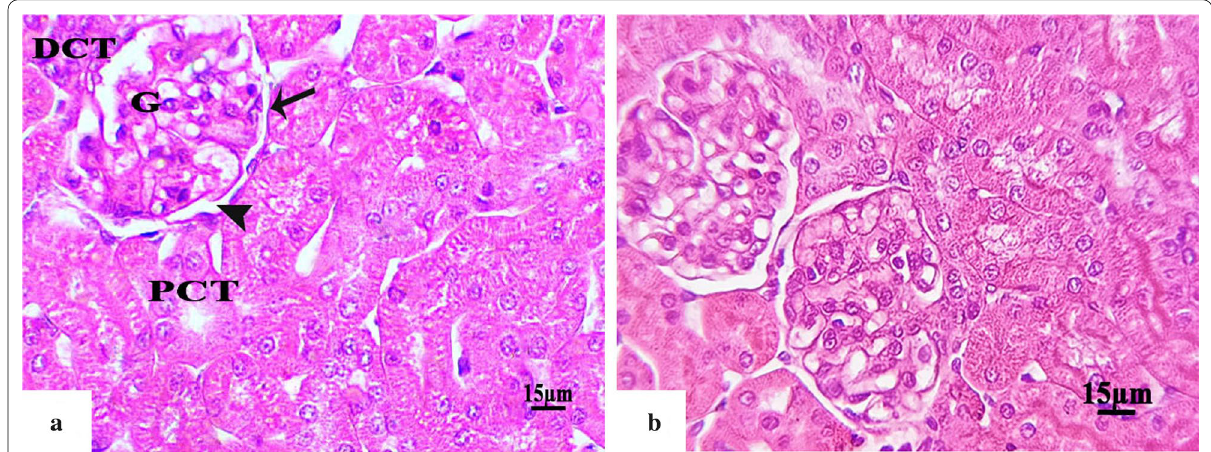
Fig. 1 Photomicrographs obtained from kidney sections of a control rat showing normal glomerulus (G), Bowman’s capsule (arrow), urinary space (arrowhead), proximal and distal convoluted tubules (PCT and DCT, respectively), b MO oil-treated rat showing nearly normal renal cortex, (H&E, X